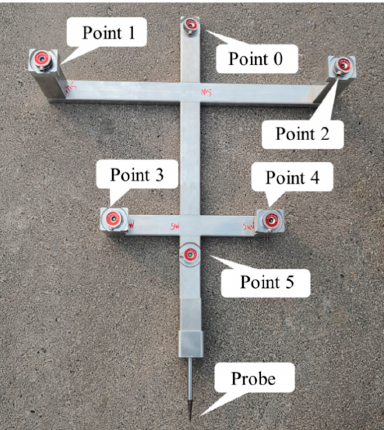
Figure 5. Multipoint (N = 6) receiver array employed for verification testing of the proposed calibration method, where the probe is docked with the target point to be measured.